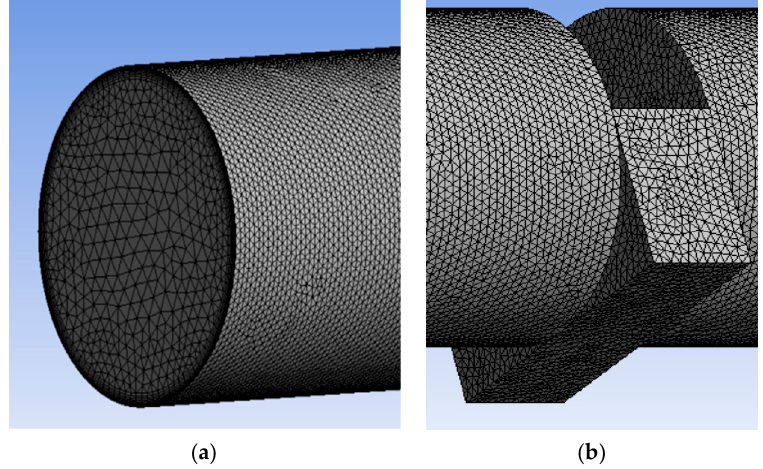
Figure 20. The mashing result; ( a ) Partial view; ( b ) Partial view.